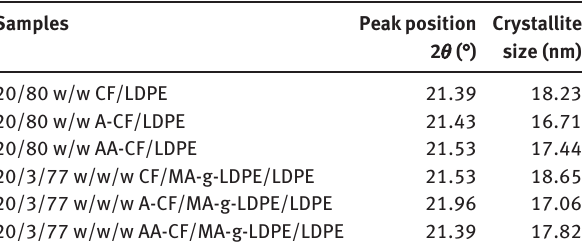
Table 1: Crystalline peaks position and crystallite size of CF/LDPE composites by